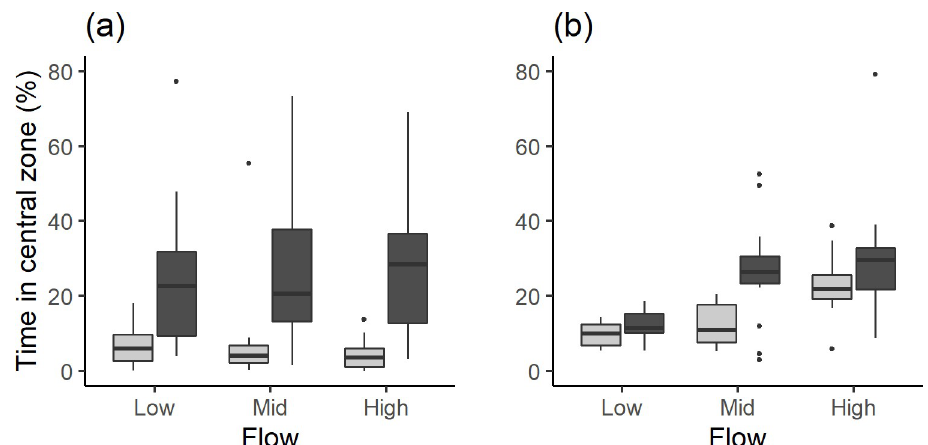
Fig 2. The percentage of time spent in the central zone of a flume with (dark grey) and without visual cues (light grey– the control) under three flow velocities for (a) common minnow and (b) brown trout.